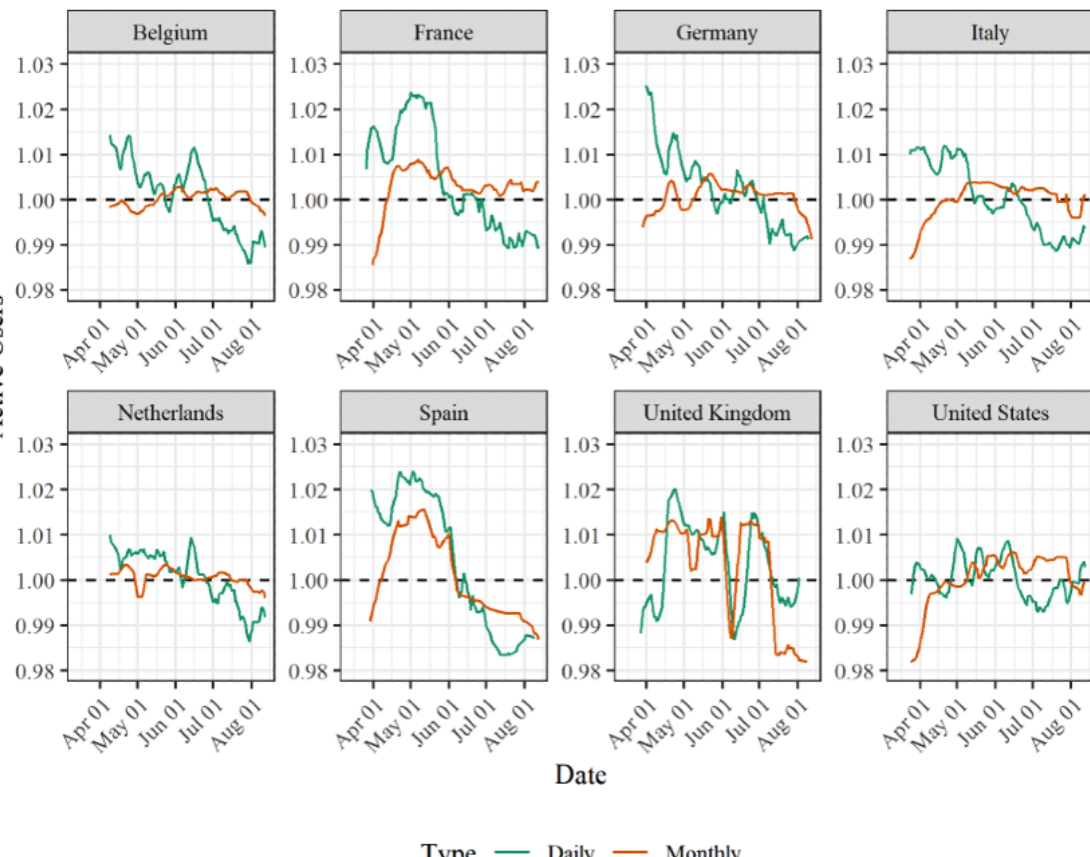
Figure 3. Number of DAUs and MAUs between March 13 and August 12, 2020 across the 8 countries based on all ad sets. Numbers were standardized for each country by dividing the value for a given day by the average number of DAUs/MAUs over the entire observation period. Lines show 7-day moving averages. We collected DAU and MAU values every 6 hours, as these estimates can change within 1 day. We averaged these multiple observations to obtain 1 number per day. Data collection started between March 18 and April 4; no data was collected on April 11, April 12, and between August